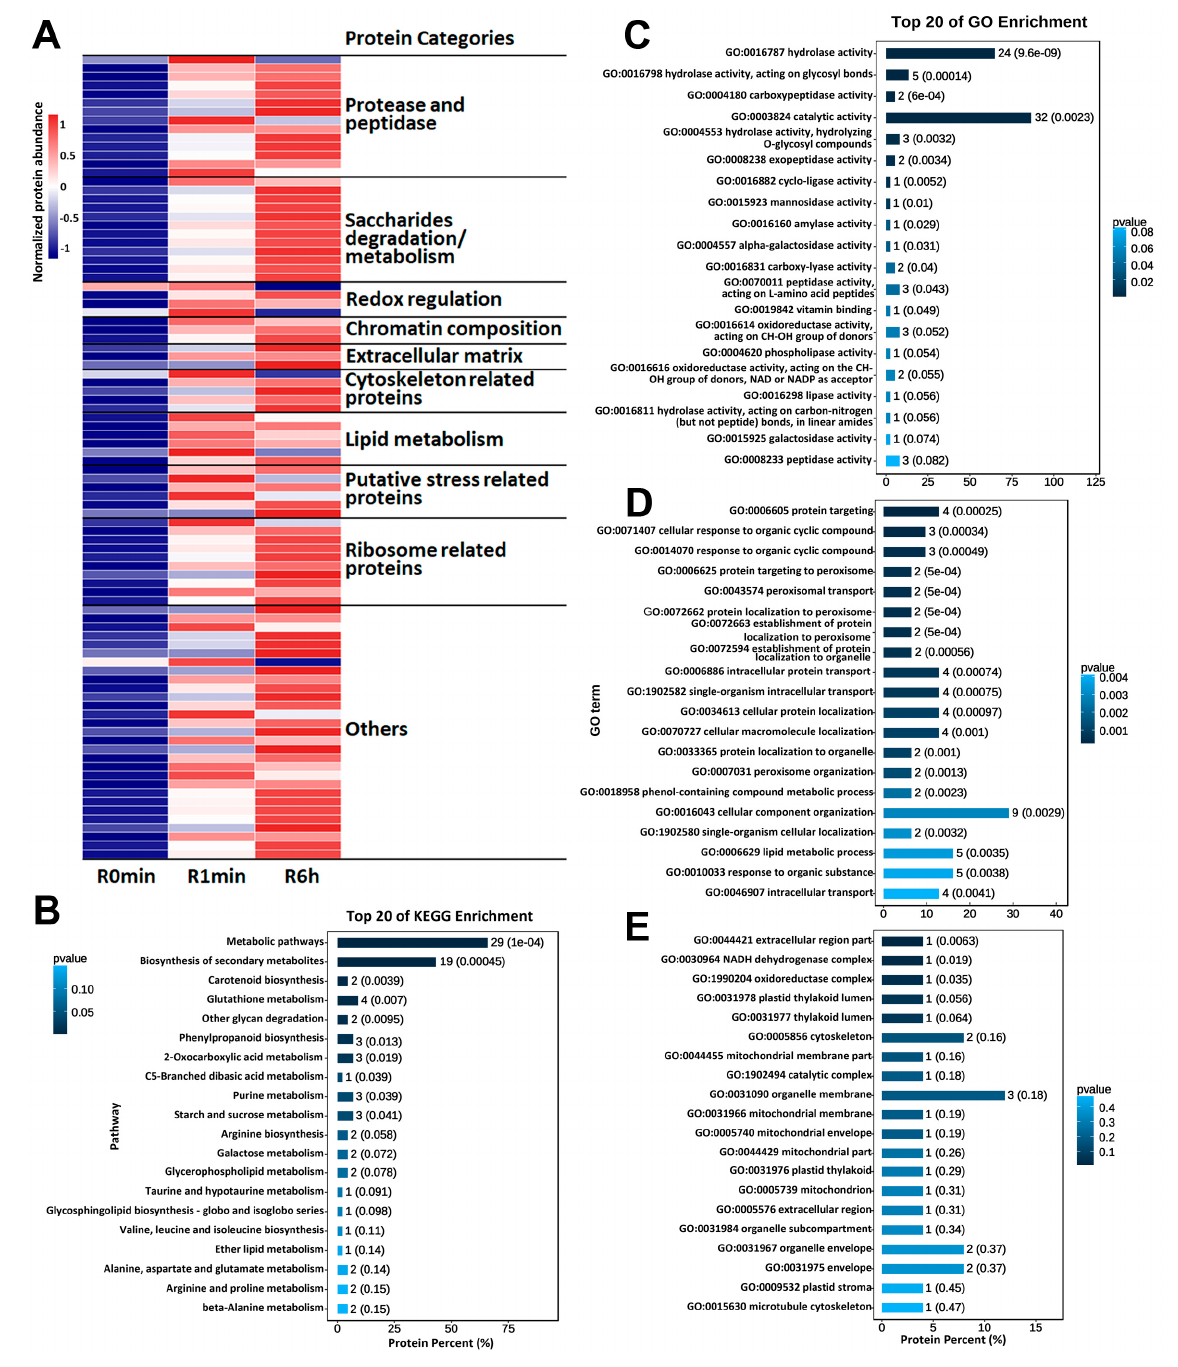
Figure 4. Relative amount, Kyoto Encyclopedia of Genes and Genomes (KEGG) database pathway enrichment, and Gene Ontology (GO) term enrichment of increased accumulated proteins: ( A ) heatmap representation of relative expression levels of increased accumulated proteins after rehydration; ( B ) the top 20 enriched KEGG pathways; ( C ) the top 20 enriched molecular function GO terms; ( D ) the top 20 enriched biological process GO terms; ( E ) the top 20 enriched cellular component GO terms. In heatmaps, the relative amount of each protein was normalized independently using the Z-score method. R0min, desiccated R. canescens ; R1min, R6h: R. canescens rehydrated for 1 min or 6 h,